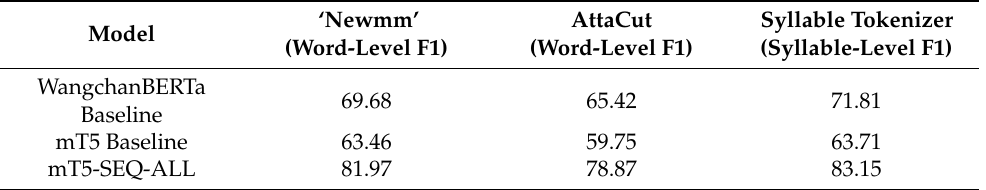
Table 12. The result of Word-level F1 with different types of tokenizers of the iApp Wiki QA dataset.